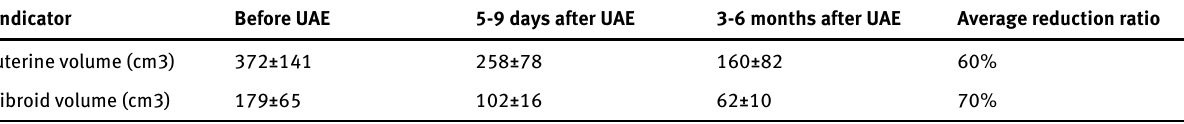
Table 2. Size changes of uterus and fibroid before and after UAE